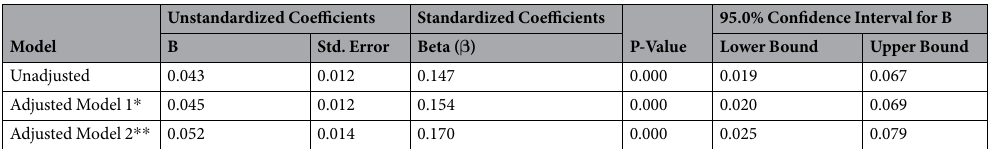
Table 3. Linear regression model for overall population. * Adjusting for Age, Gender, Ethnicity, BMI,